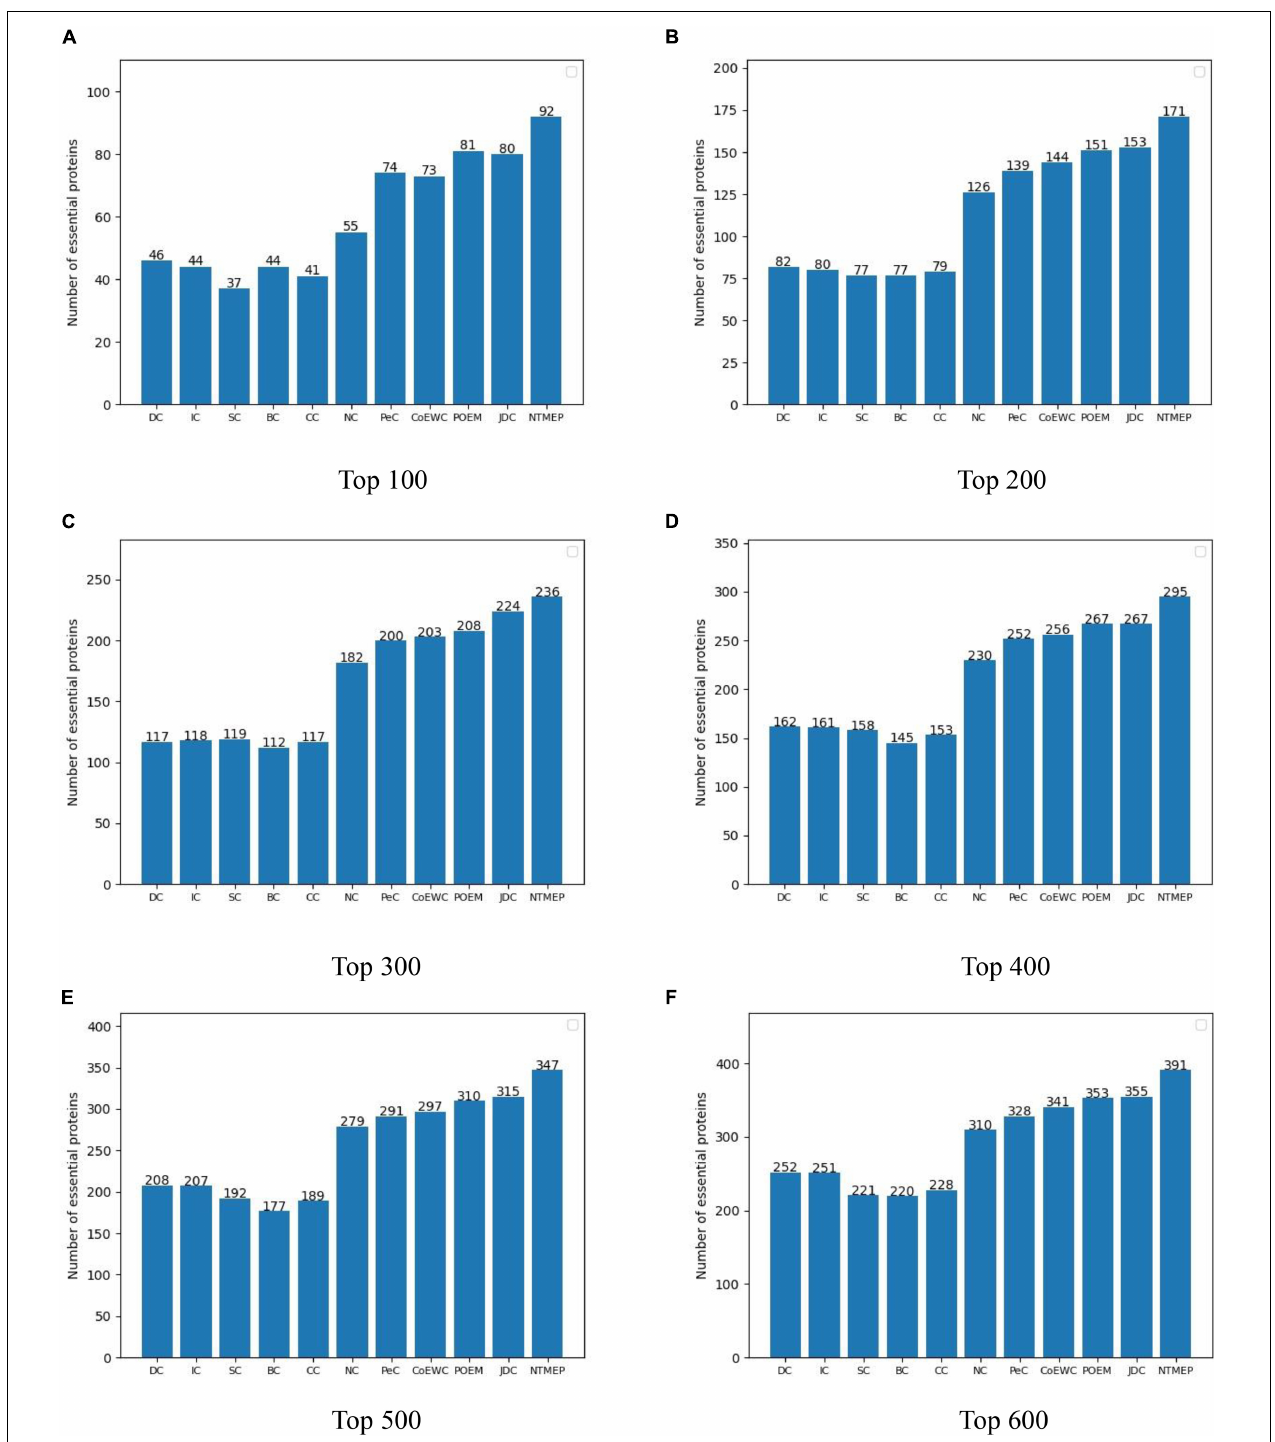
FIGURE 1 | Number of actual essential proteins identified by NTMEP and other ten previously competitive methods at various k values. (A) Top 100 ranked proteins; (B) Top 200 ranked proteins; (C) Top 300 ranked proteins; (D) Top 400 ranked proteins; (E) Top 500 ranked proteins; (F) Top 600 ranked proteins.